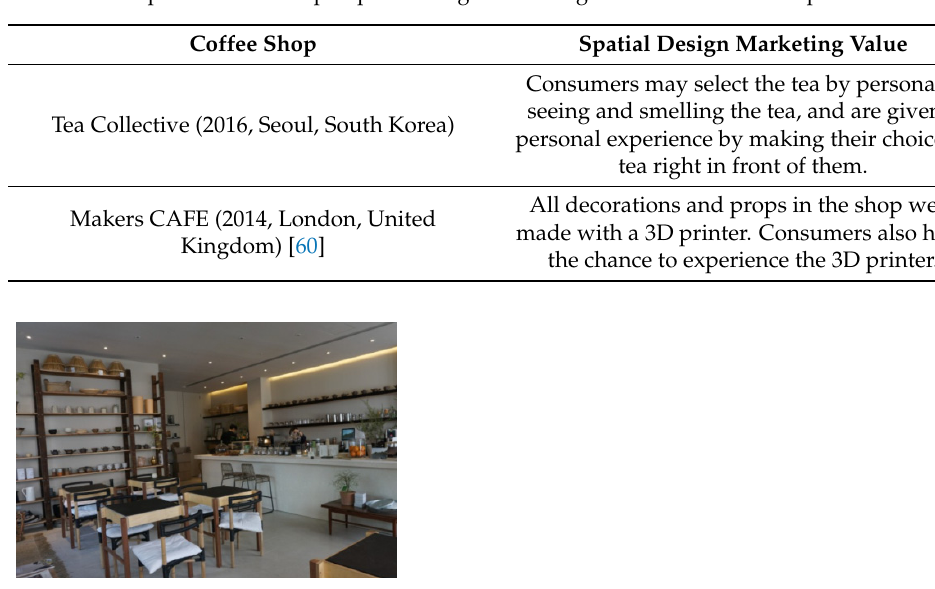
Table 9. Examples of coffee shops’ spatial design marketing associated with the experiential element.